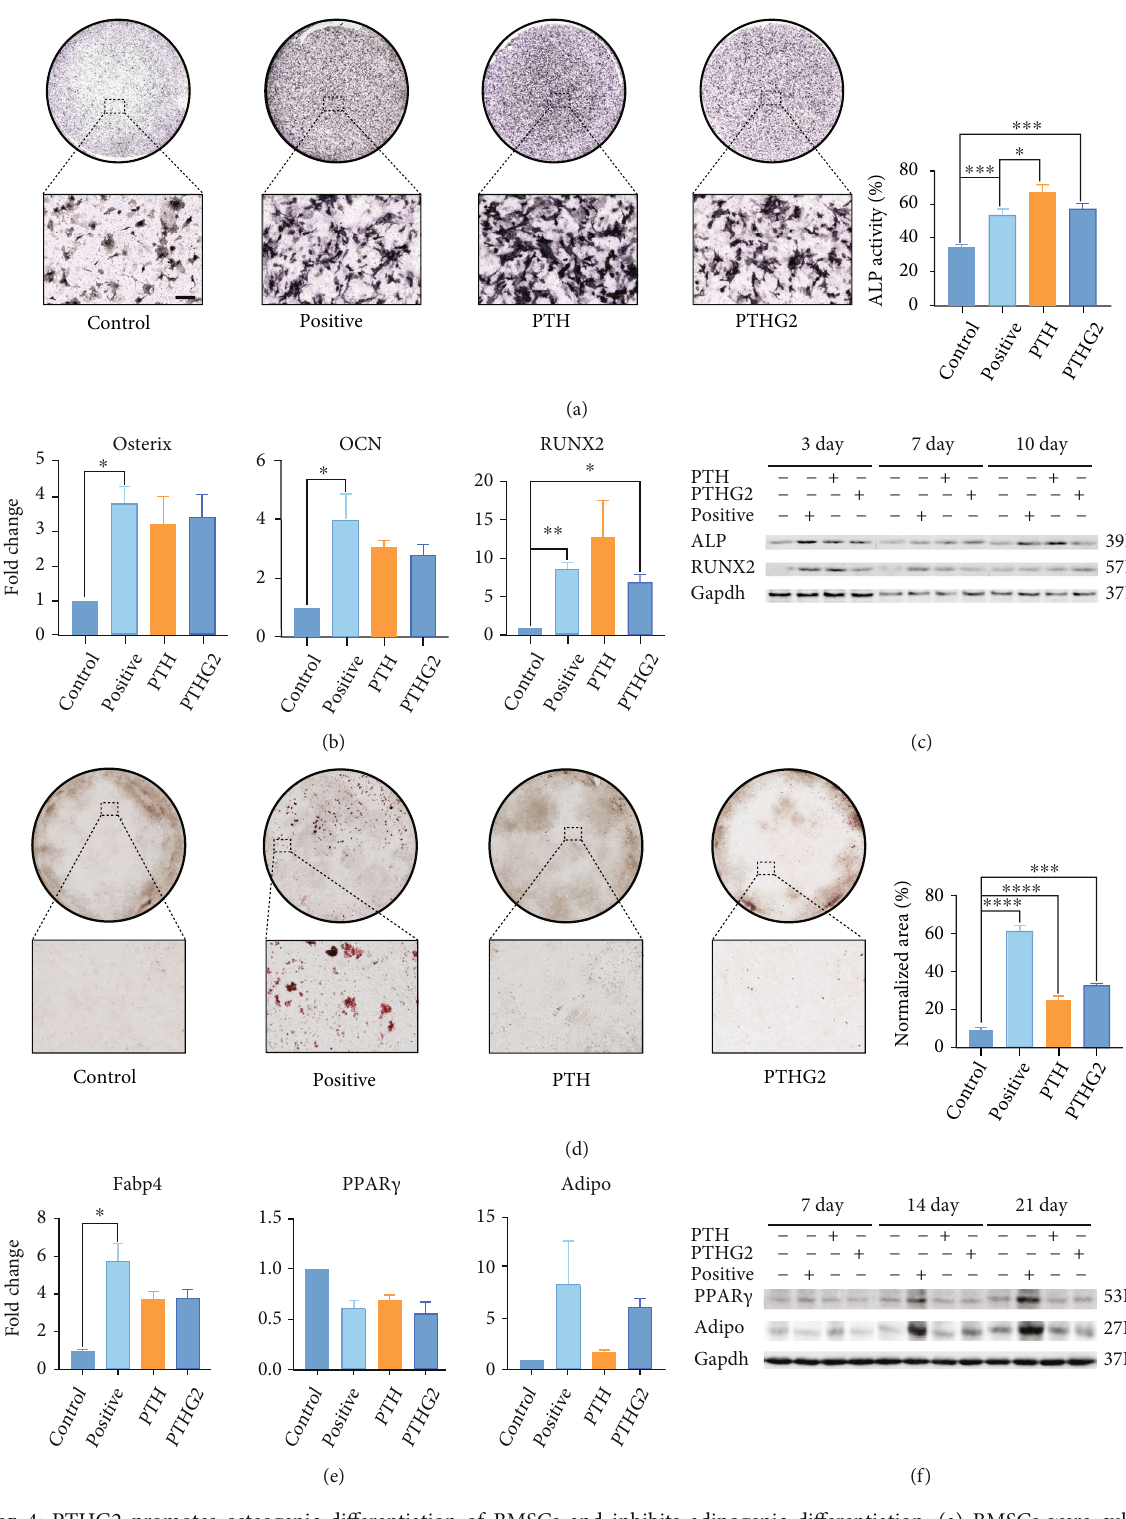
Figure 4: PTHG2 promotes osteogenic di ff erentiation of BMSCs and inhibits adipogenic di ff erentiation. (a) BMSCs were cultured in osteoblast medium for 7 days, and the ALP positive area was measured. (b) The relative expression of osteoblast marker gene (OCN/Osterix/RUNX2) following PTHG2 treatment was quanti fi ed by real-time PCR. (c) Western blotting assays of ALP and RUNX2 during osteogenic di ff erentiation. (d) Oil red O staining detected the e ff ects of PTHG2 on BMSCs adipogenic di ff erentiation and quantity. (e) The relative expression of adipocyte marker gene (Fabp4/PPAR ɣ /Adiponectin) following PTHG2 treatment was quanti fi ed by real-time PCR. (f) Western blotting assays of PPAR ɣ and adiponectin during adipogenic di ff erentiation. Scale bar = 30 μ m ( n = 3 ); ∗ p < 0 : 05 , ∗∗ p < 0 : 01 , ∗∗∗ p < 0 : 001 , ∗∗∗∗ p < 0 : 001